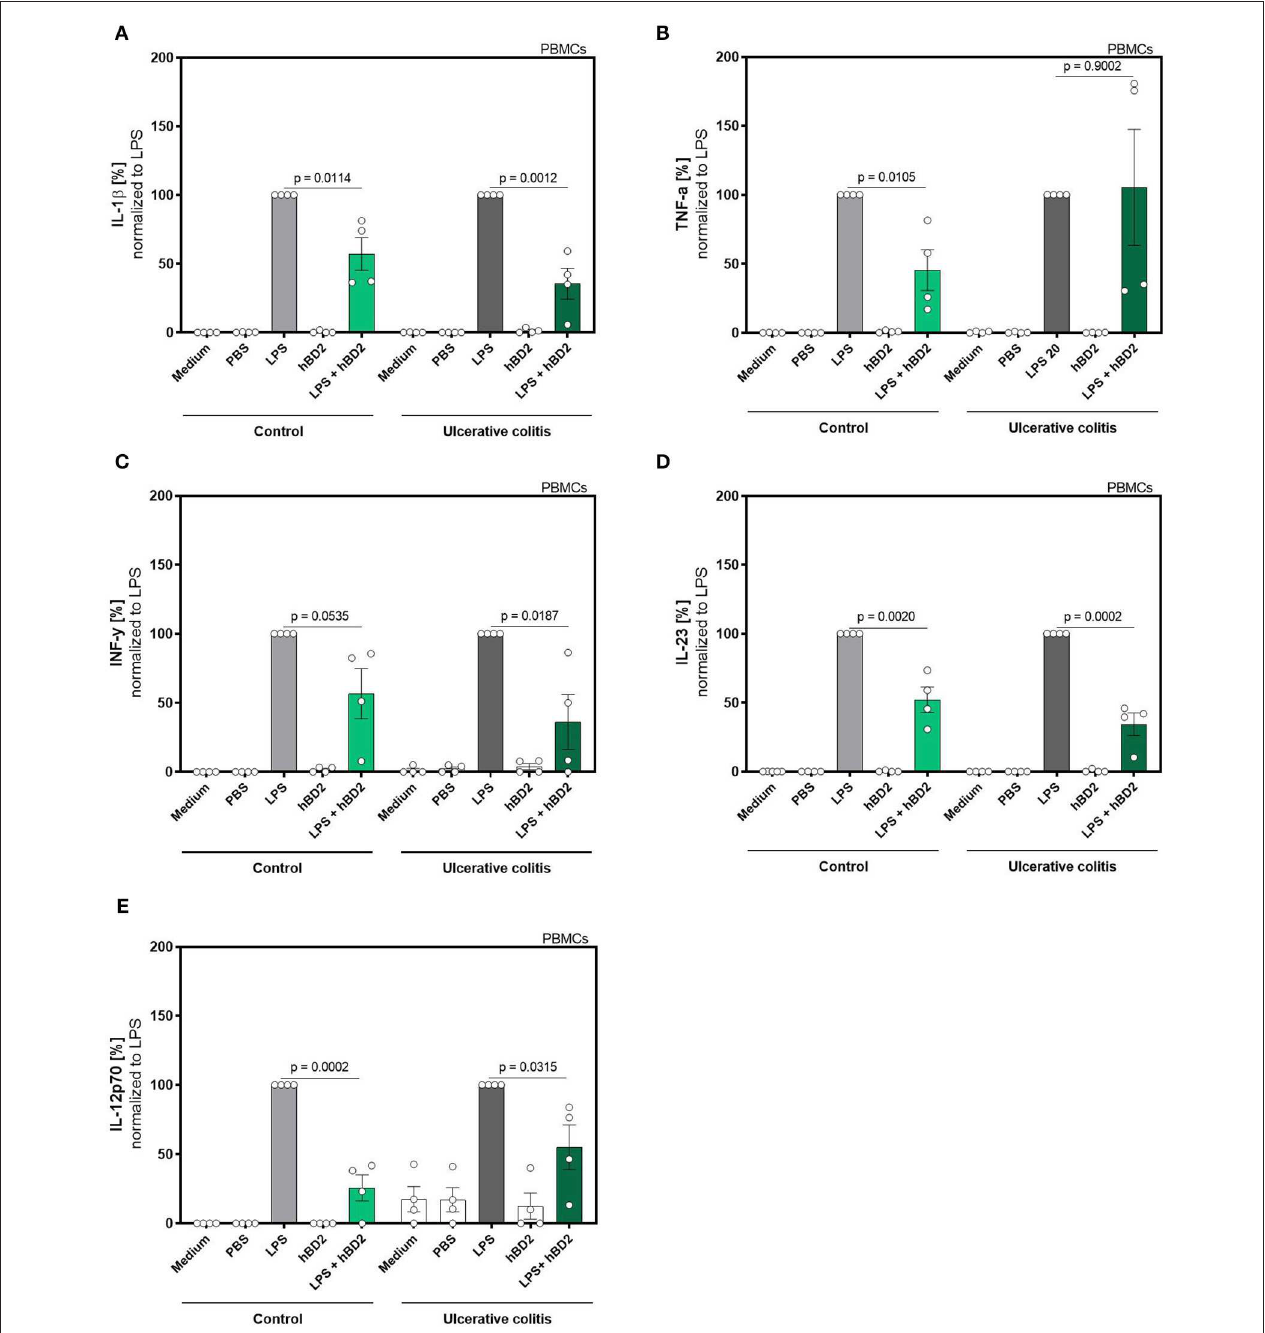
FIGURE 2 | hBD2 reduced the pro-inflammatory effect of LPS in human primary PBMC’s of ulcerative colitis patients. PBMC’s were challenged with LPS (20 pg/ml) and treated with 10 µ g/mL hBD2. Release of of (A) IL-1 β , (B) TNF- α , (C) INF-y, (D) IL-23, and (E) IL-12p70 is shown in % normalized to LPS. Data are presented as mean ± SEM ( n = 4) and analyzed by unpaired t -test.